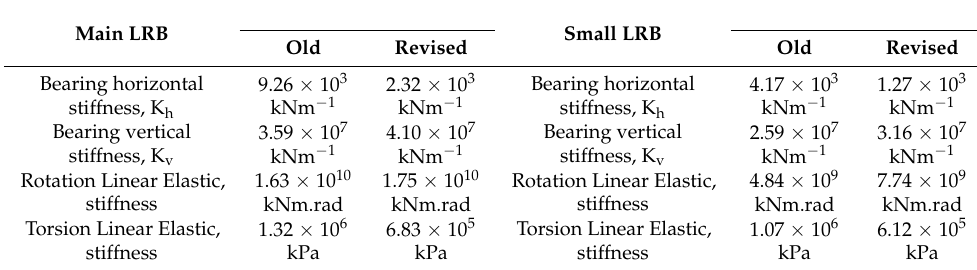
Table A8. Revised LRB Parameters.